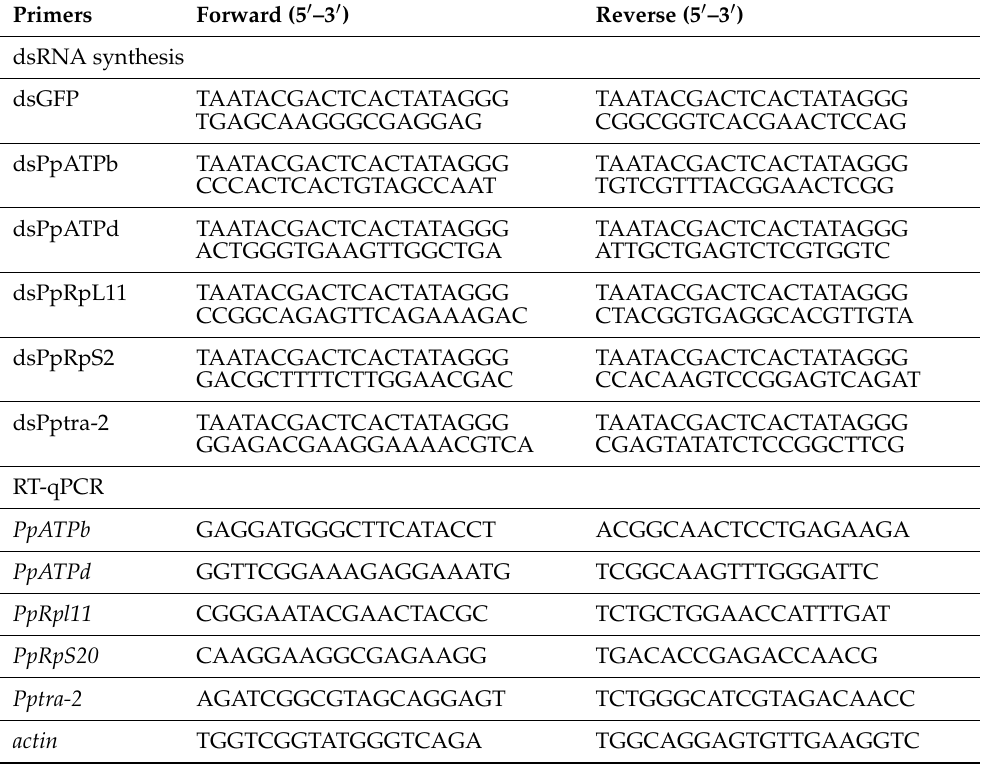
Table 1. All primers used for dsRNA synthesis and RT-qPCR.